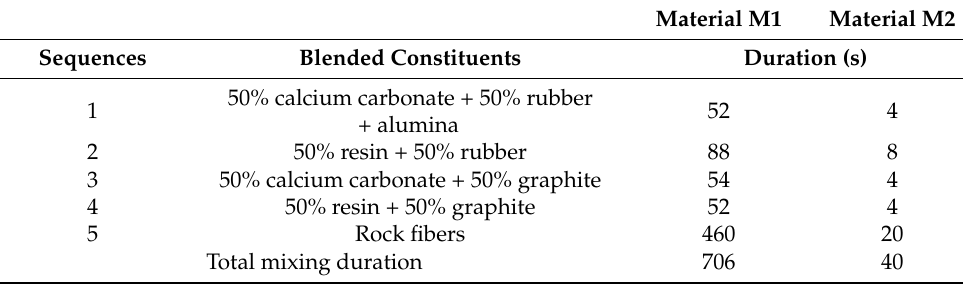
Table 2. Mixing parameters of simplified material